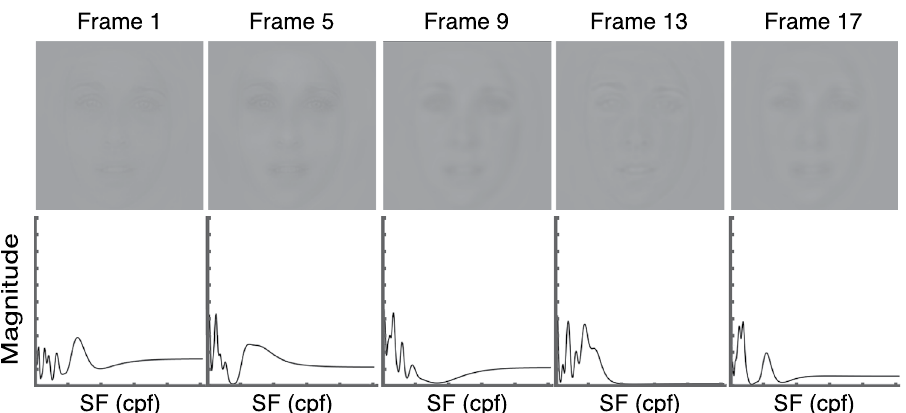
Figure 1. Example of a sequence of the SFs sampled across time, with the resulting image, for one trial. In order to save space, only a subset of the 18 frames were selected for